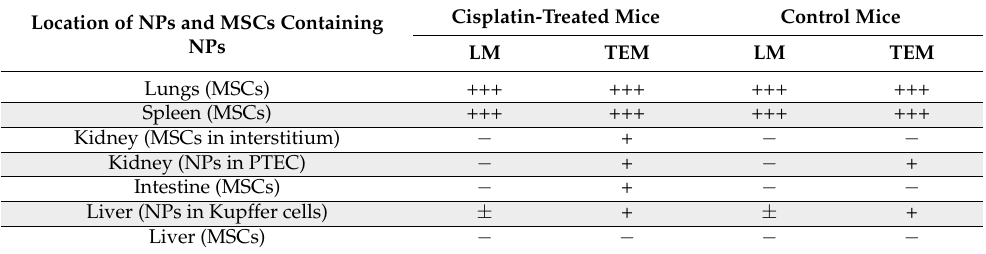
Table 1. Localization and semi quantitative assessment of nanoparticles and MSCs containing nanoparticles by light and transmission electron